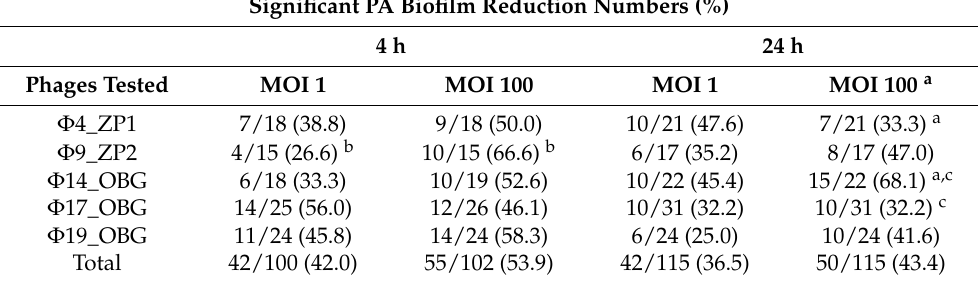
Table 2. In vitro activity for the five newly isolated lytic phages ( Φ 4_ZP1, Φ 9_ZP2, Φ 14_OBG, Φ 17_OBG, Φ 19_OBG) at multiplicity of infection (MOI) 1, and MOI 100 tested against the 24-h-old- preformed Pseudomonas aeruginosa (PA)